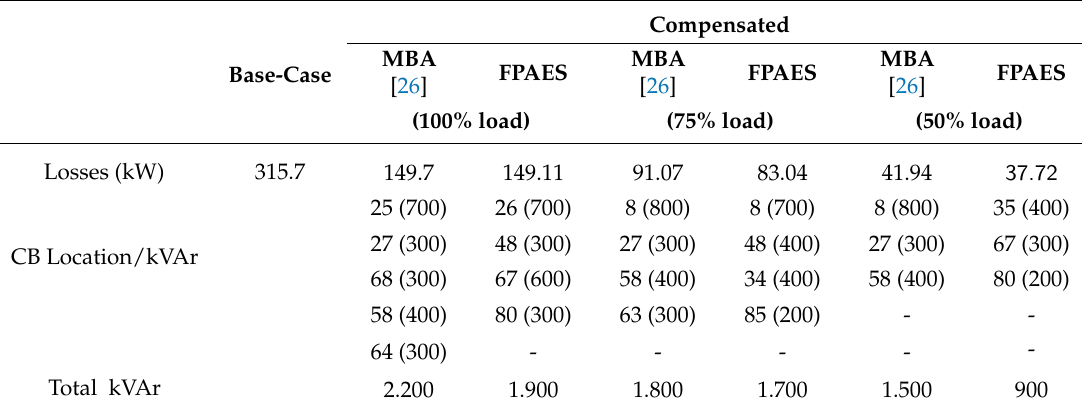
Table 7. Simulation results for the 85-bus system with load